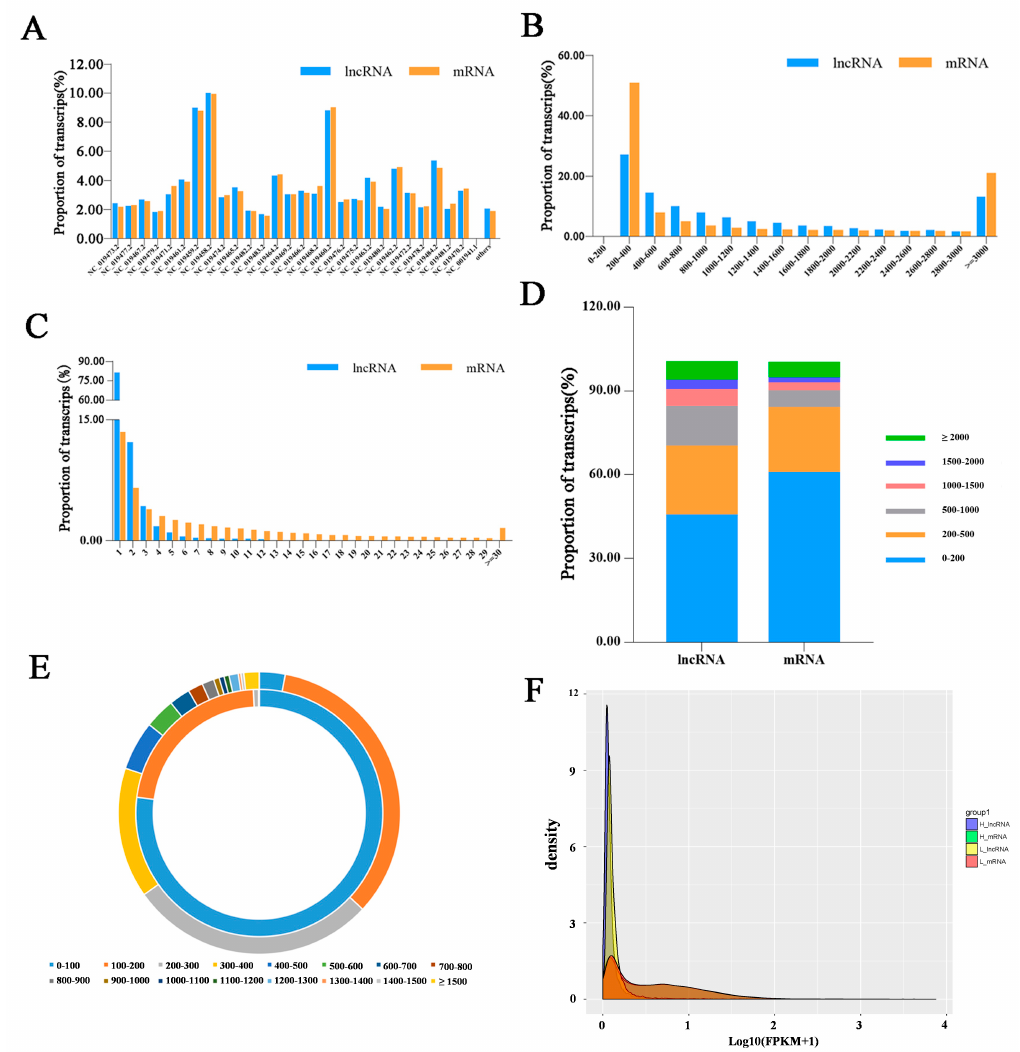
Figure 2. Identification of lncRNAs and protein-coding genes in Hu sheep pituitary. ( A ) Distribution of lncRNAs and protein-coding genes in chromosomes. ( B ) Length of lncRNAs and protein-coding genes. ( C ) Exon content of lncRNAs and protein-coding genes. ( D ) Exon size distribution of sheep lncRNAs and protein-coding genes. ( E ) Length of the open reading frame (ORF) of lncRNAs and protein-coding genes. ( F ) The Fragments Per Kilobase of transcript per Million fragments mapped (FPKM) levels of lncRNA and protein-coding genes in the H and L group.